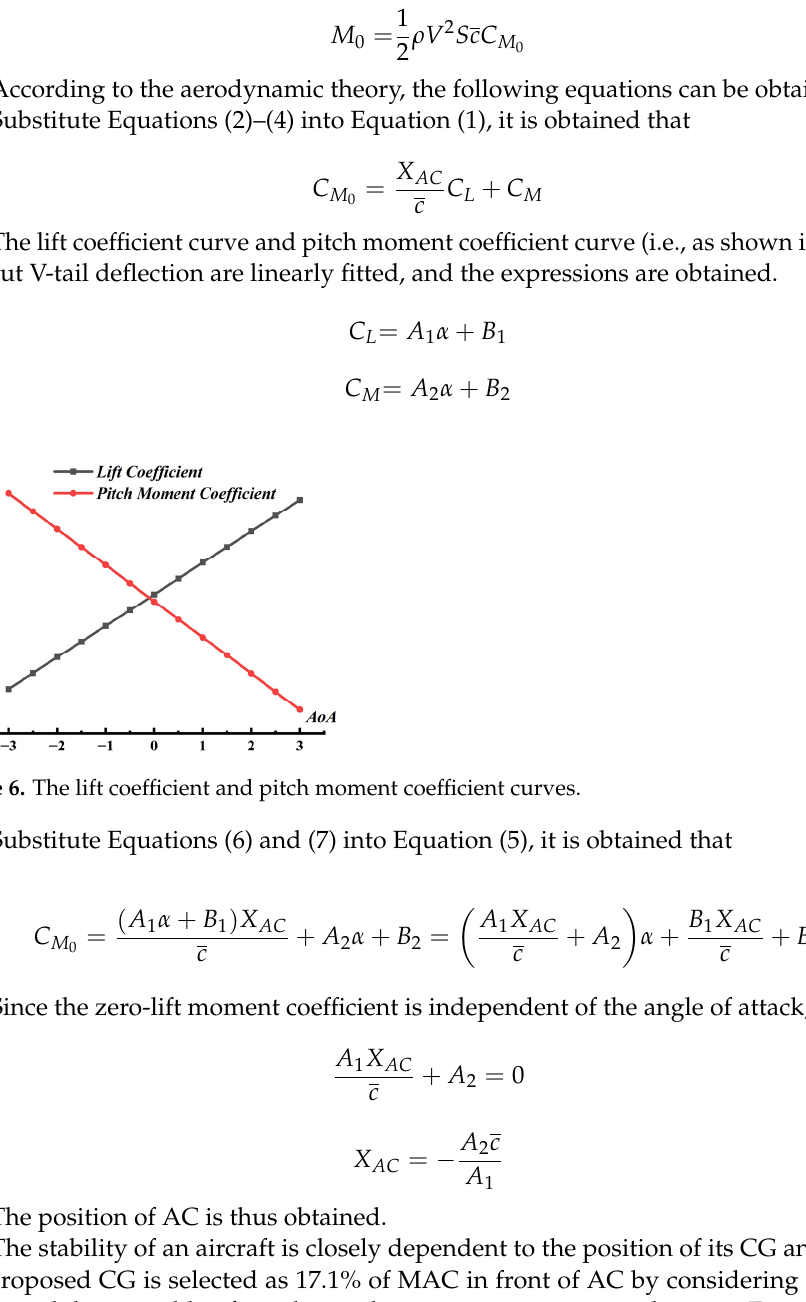
Figure 5. Force analysis of the aircraft.